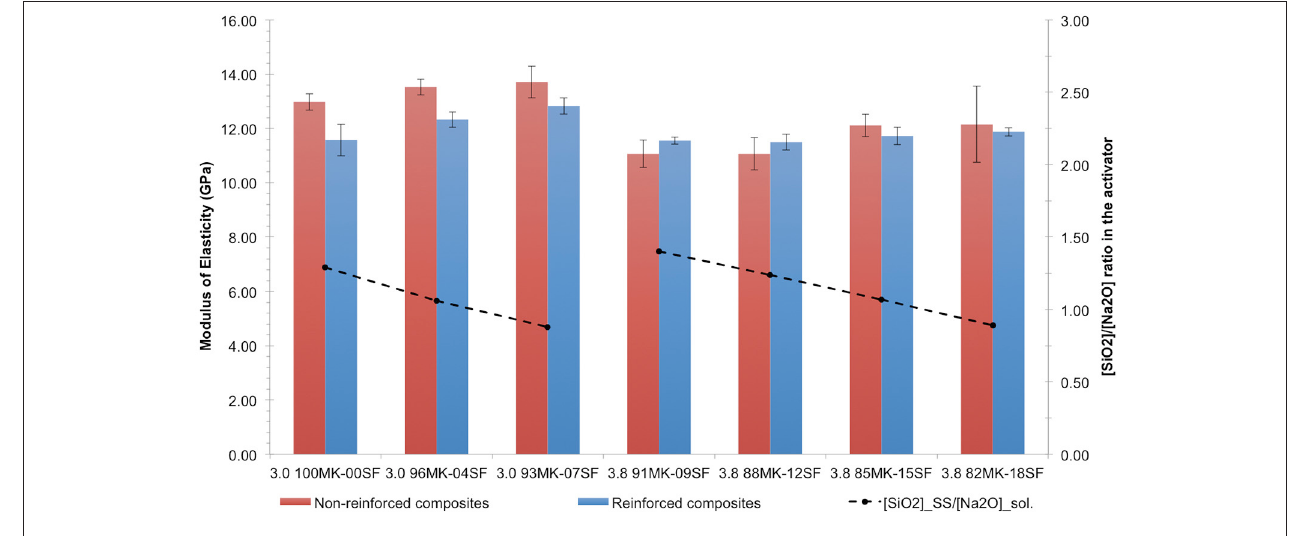
FIGURE 6 | Modulus of elasticity